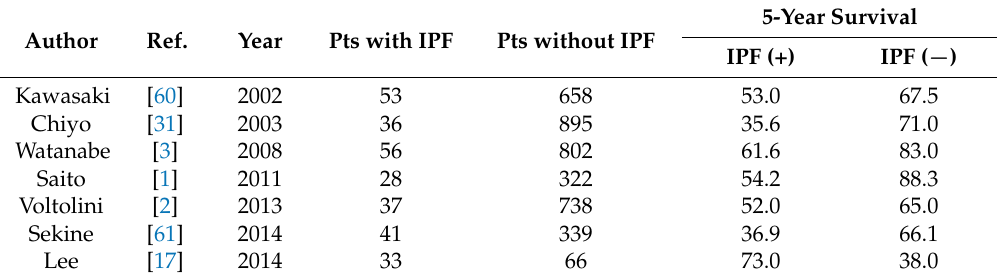
Table 2. Reports on the long-term outcome of non-small cell lung cancer patients with idiopathic pulmonary fibrosis after lung